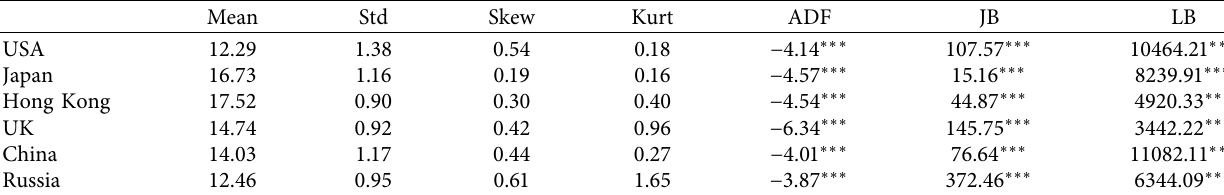
Table 2: Descriptive